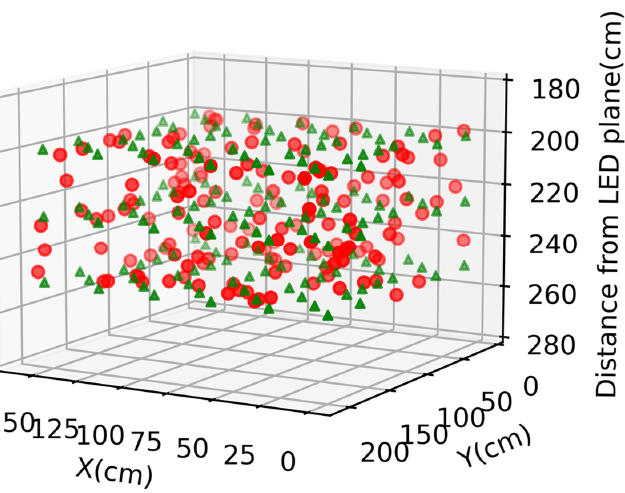
Figure 10. Three-dimensional visualization combining the 250, 225, and 200 cm Rx planes using the TSNN with RISE; green triangles and red circles are actual and predicted 3D locations.